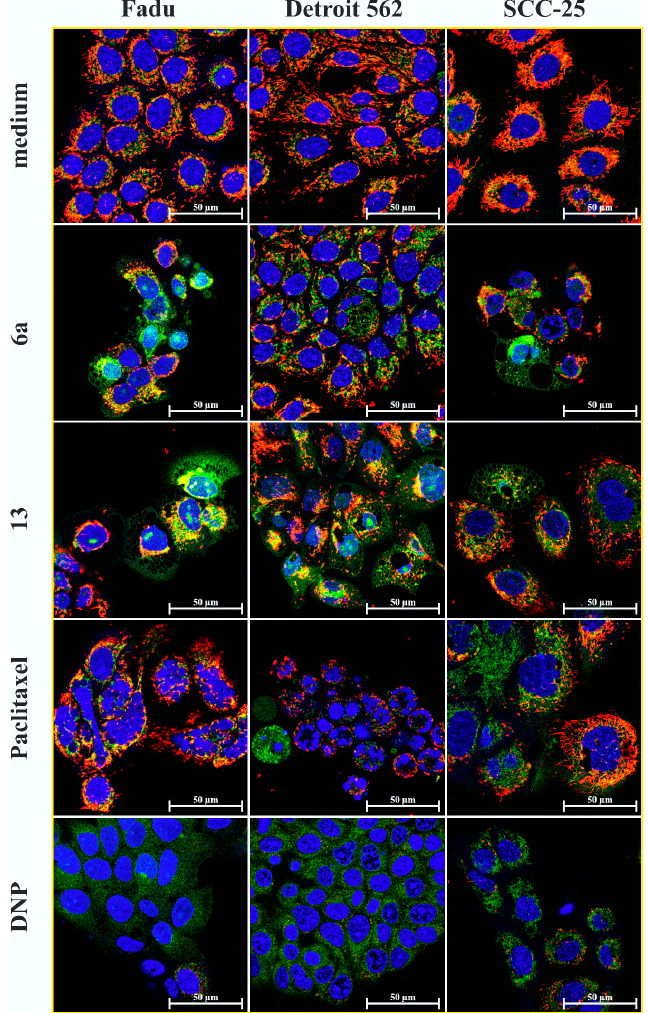
Figure 7. Mitochondrial Membrane Potential Using the Cationic JC-1 Dye. Nontreated cells were used as negative control, with their well-functioning mitochondria represented with red color. Mitochondrial uncoupling agent 2,4-Dinitrophenol (DNP) was used a positive control. Diffusive green color indicates the diminished mitochondrial membrane potential in DNP-treated cells. Hybrids 6a and 13 resulted in significant mitochondrial dysfunction (at 2.5 μ M after 28 h treatment) in HNSCC cells. Nuclei were visualized by membrane-permeable dye DRAQ5 (blue).